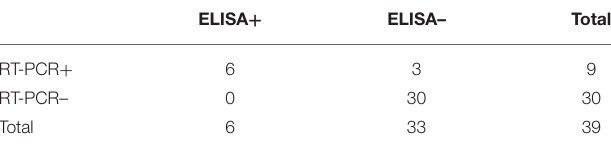
TABLE 2 | Convalescent serology testing of ambulatory